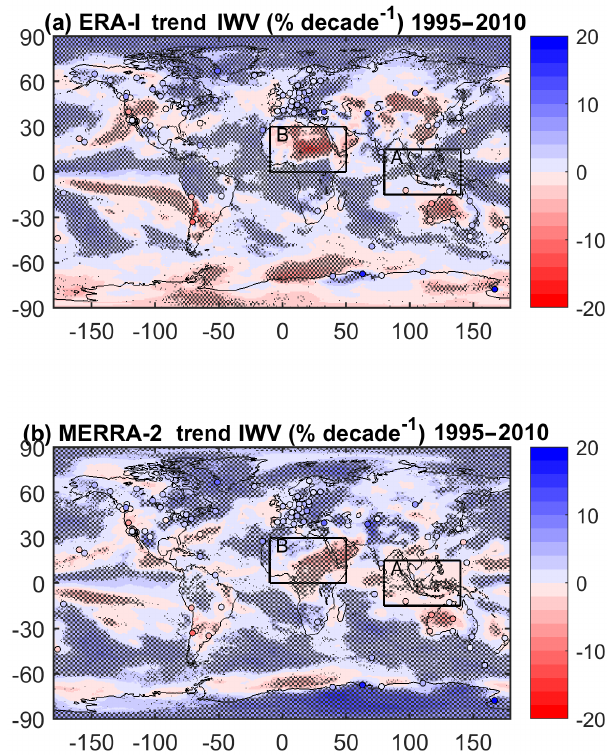
Figure 5. Relative IWV trends (in %decade − 1 ) for the 1995–2010 period from GPS (stations marked as circles), ERA-Interim (a) , and MERRA-2 (b) . The statistically significant trends from ERA- Interim and MERRA-2 are highlighted by stippling. Two regions discussed in Sect. 3.2 are outlined as box A (Maritime Continent) and box B (northern